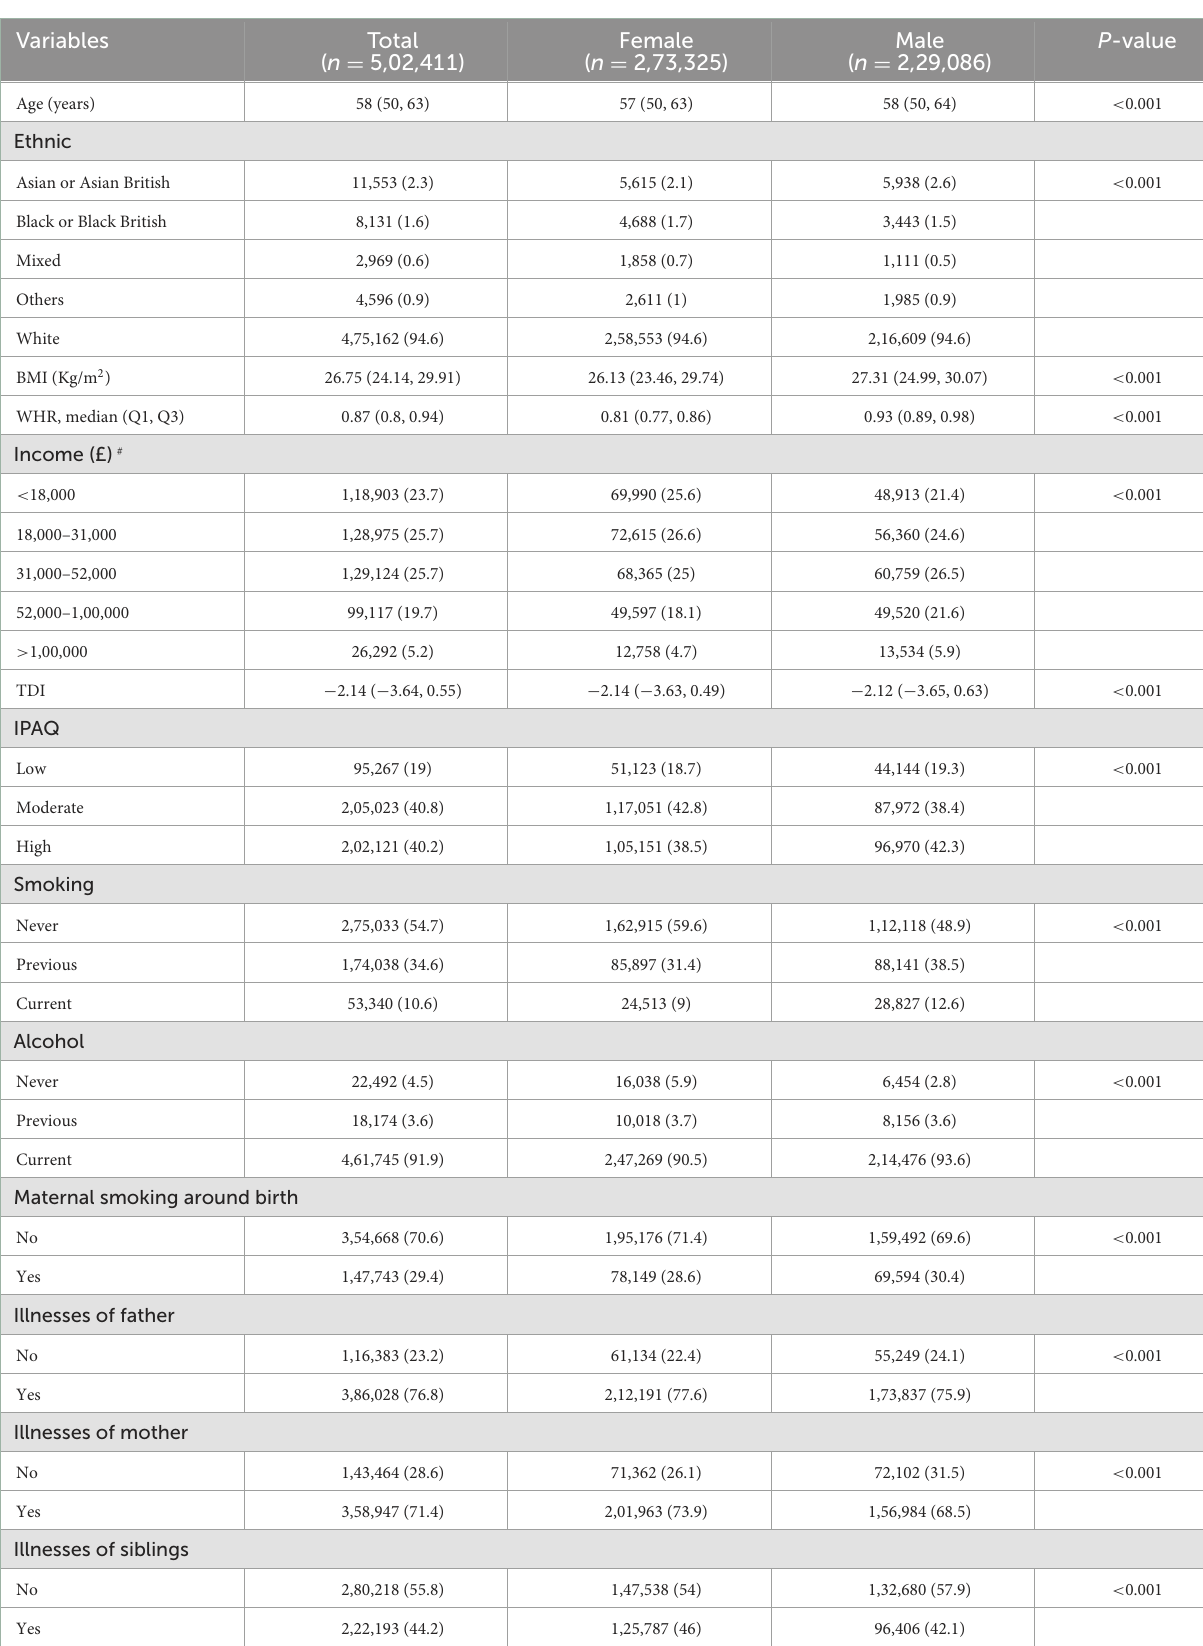
TABLE 3 Differences in characteristics between males and females [Median (Q1, Q3)/ n (%)].